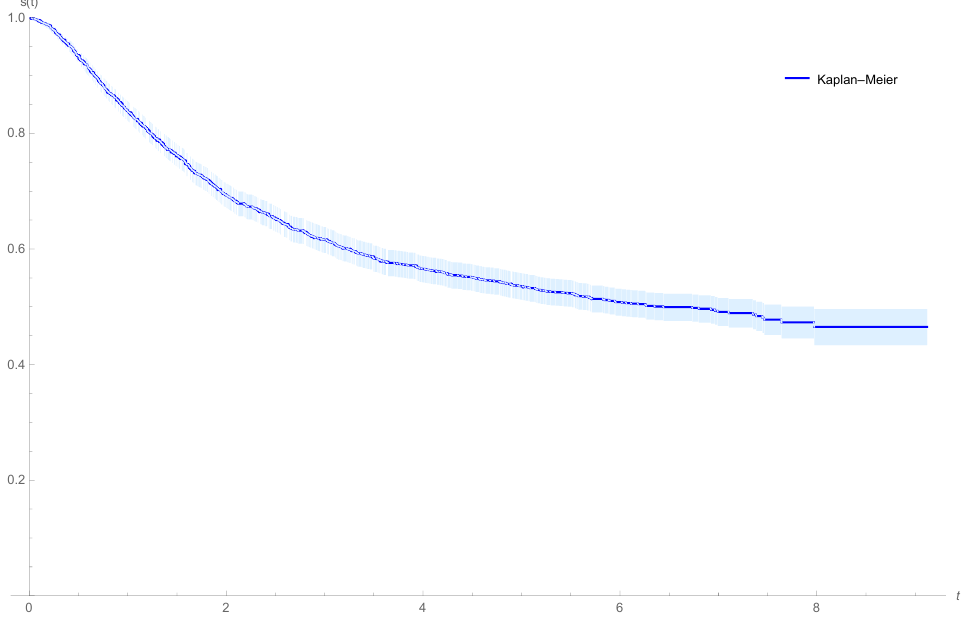
Figure 2. Kaplan–Meier curve for the colon